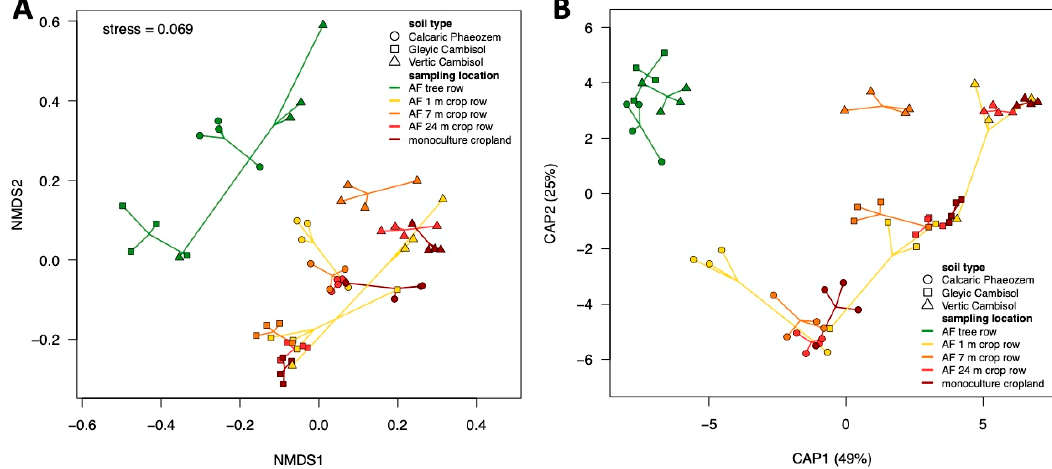
Figure 4. Beta diversity of soil fungal communities in paired temperate agroforestry and monoculture cropland systems. ( A ) Non-metric multidimensional scaling (NMDS) and ( B ) canonical analysis of principal coordinates (CAP) for pairwise Bray–Curtis dissimilarities; samples from each location are connected with their centroids. In all panels, circles, squares and triangles represent individual samples ( n = 4) from Calcaric Phaeozem, Gleyic Cambisol and Vertic Cambisol, respectively. Soil samples within each replicate plot of the temperate agroforestry croplands were collected in the centre of the tree row as well as in the crop row at 1, 7, and 24 m distance from the trees in order to cover the spatial heterogeneity of the systems. In the monoculture croplands, soil samples were collected in the centre of each replicate plot. AF = agroforestry system.